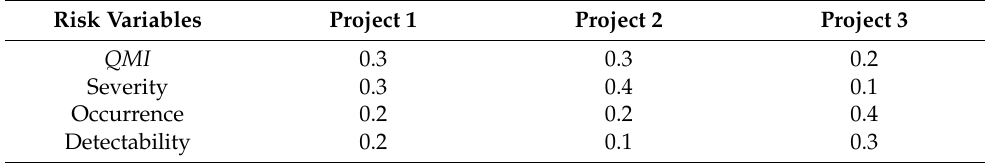
Table 9. Effective risk evaluation—weights given to the risk variables, Cases 1 to